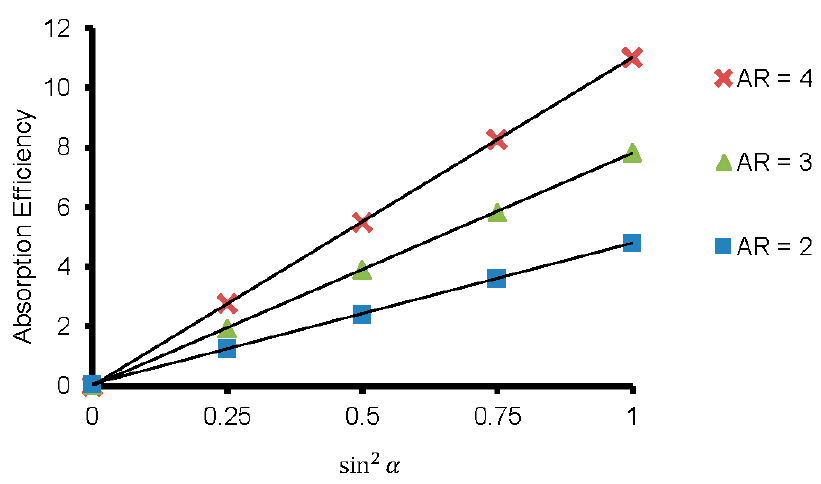
Figure 8. The linear relationship between the absorption efficiency and the orientation.